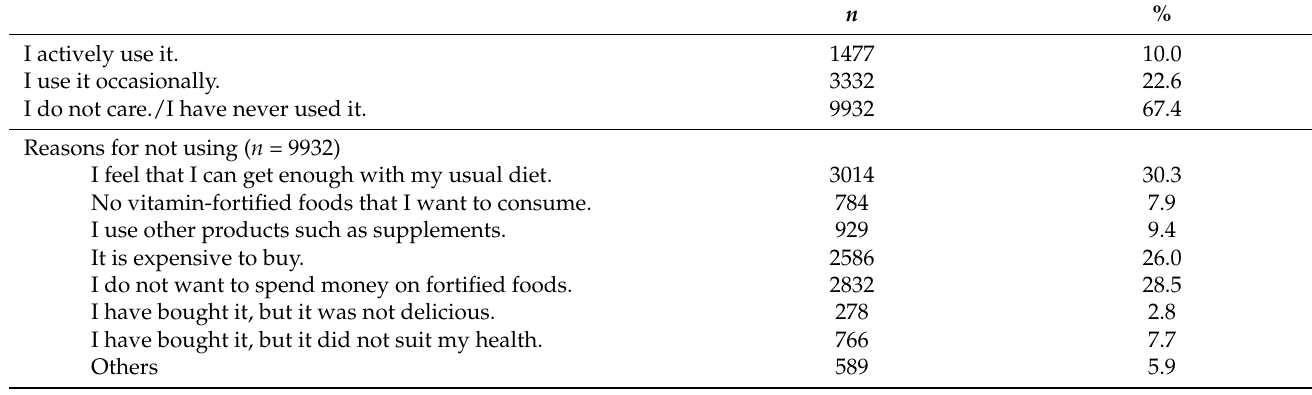
Table 2. The prevalence of vitamin-fortified food usage and reasons for non-usage.